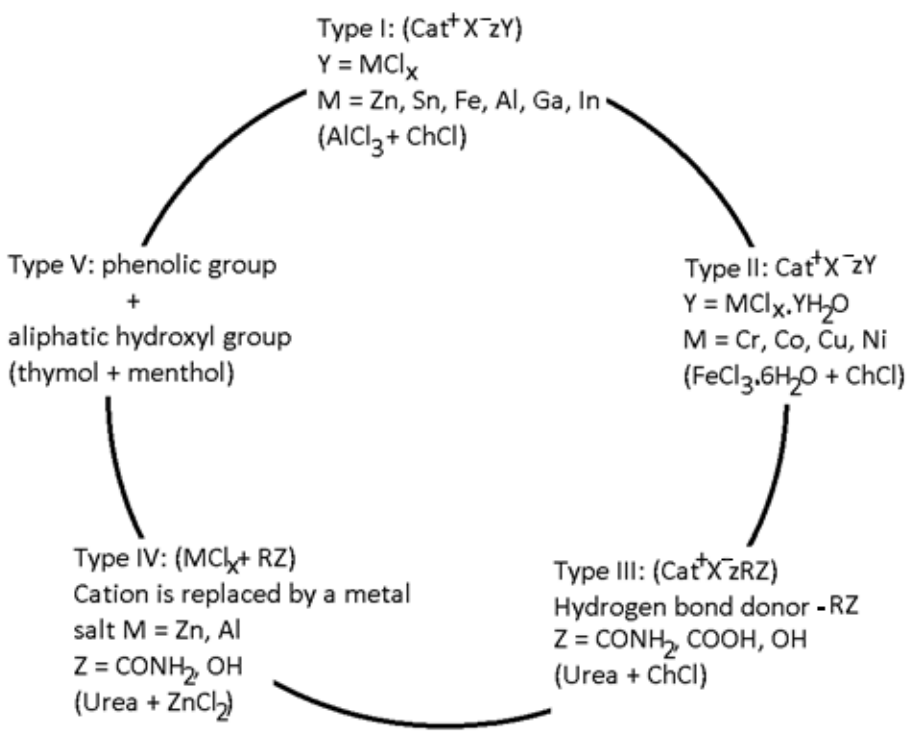
Figure 1. Types of green solvents on the basis of the general formula.